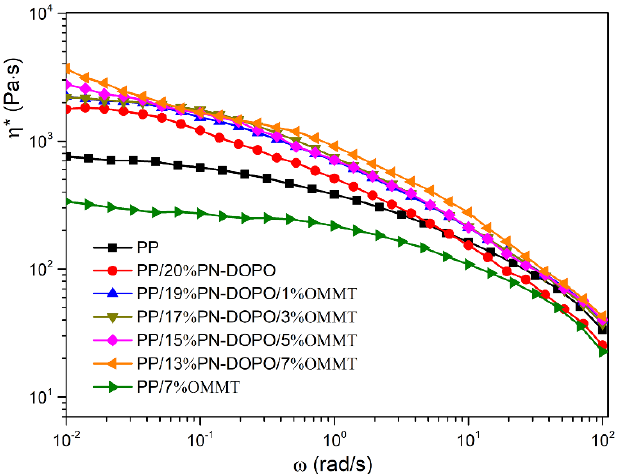
Figure 8. Complex viscosity versus frequency of PP and flame-retarded PP composites.